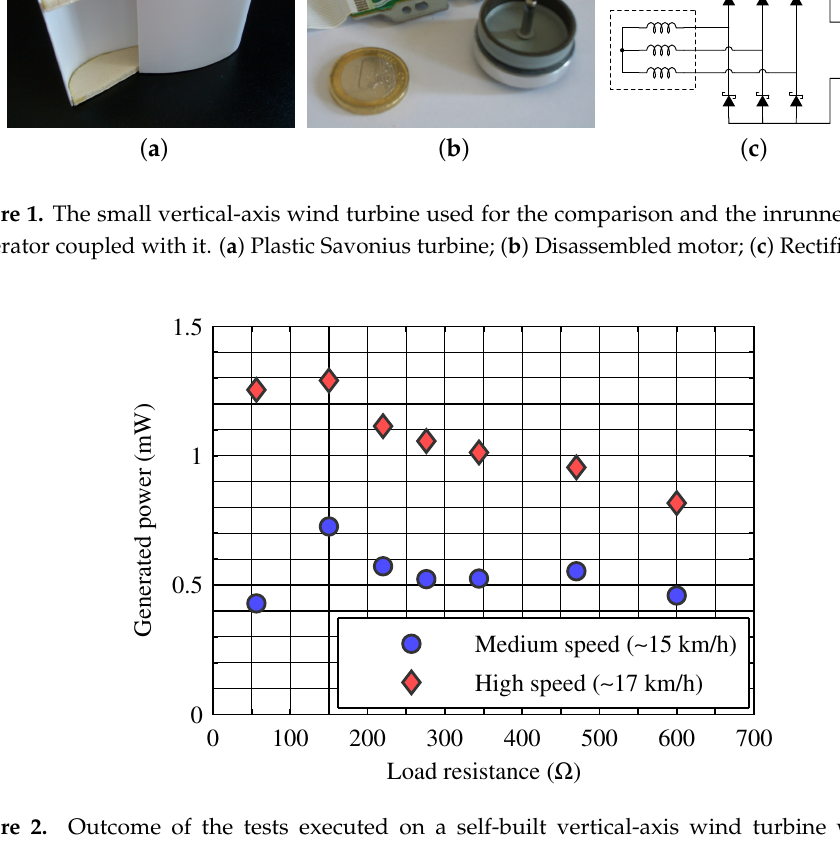
Figure 2. Outcome of the tests executed on a self-built vertical-axis wind turbine with a size below 100cm 3 . The maximum power obtained using a 17km · h − 1 wind has been of about